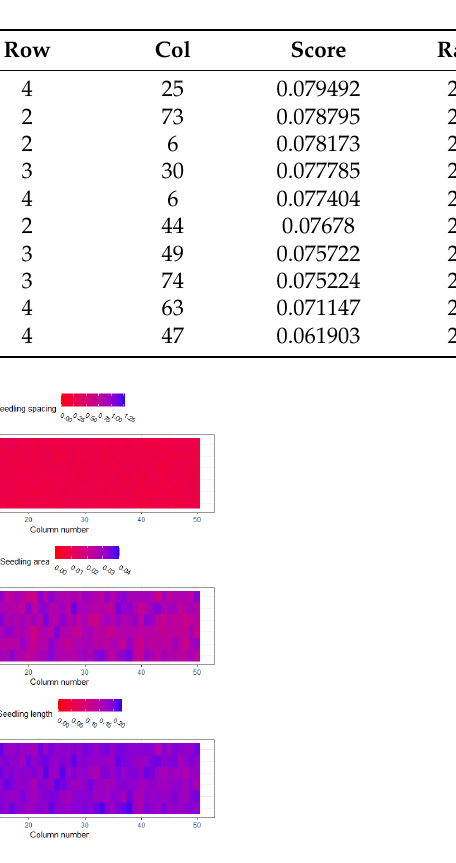
Figure 6. The growth and distribution characteristics of maize seedlings at Zhangye Station in 2021. CV: the coefficient of variation.